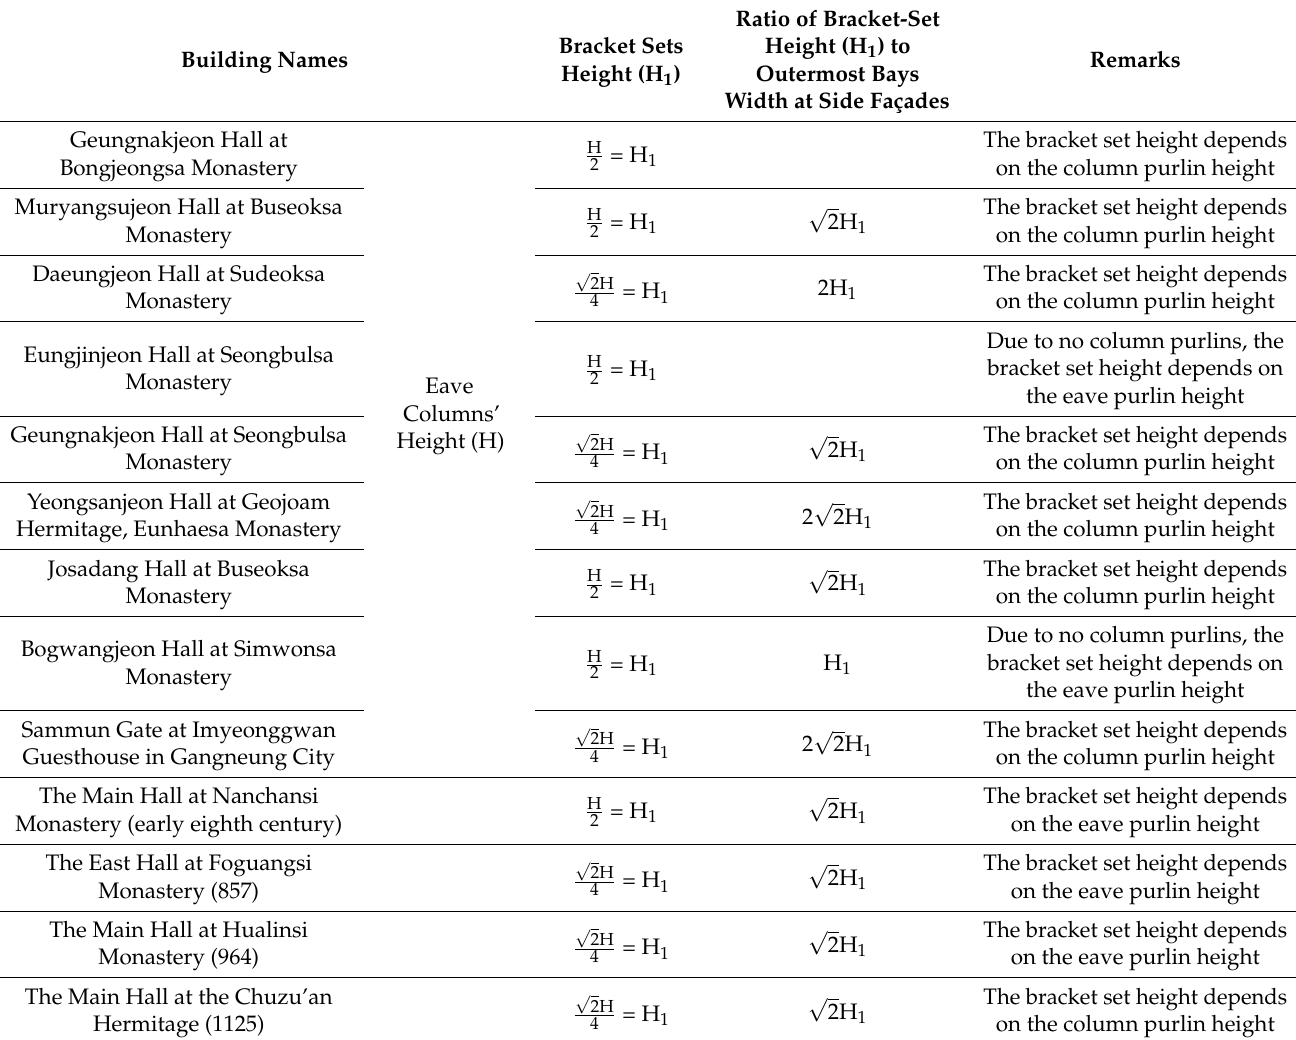
Table 5. The proportional relationship between bracket set height and outermost bay